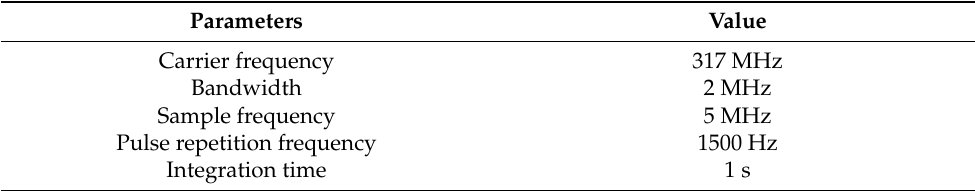
Table 5. Radar system parameters for real